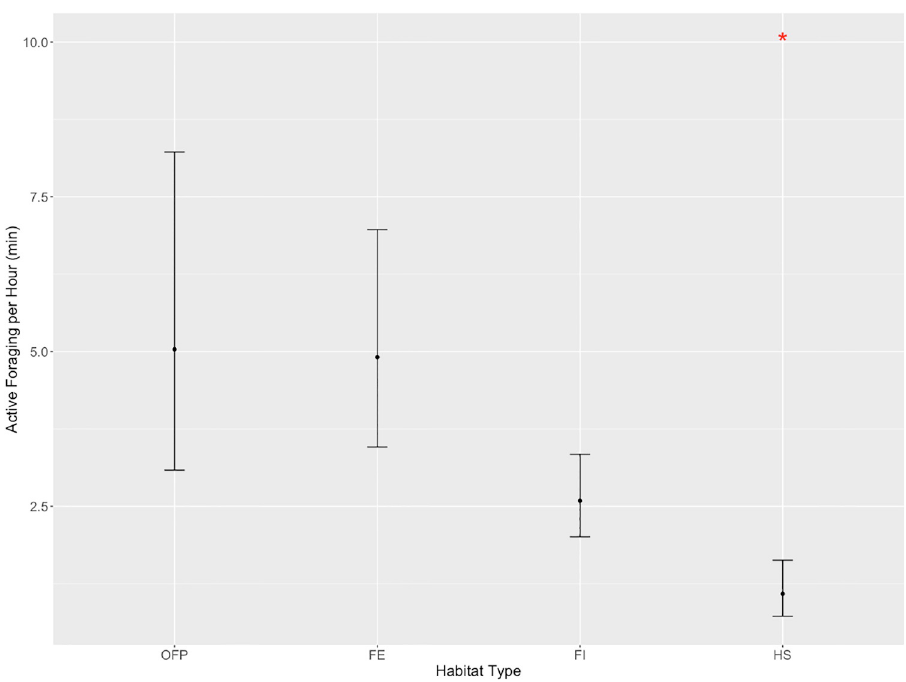
Fig 3. Predicted mean active foraging per hour across habitat types, with 95% confidence intervals. � Statistically significant at p � 0.05. FE = Forest Edge, FI = Forest Interior, OFP = Open Forest Patch, HS = Human Settlement.